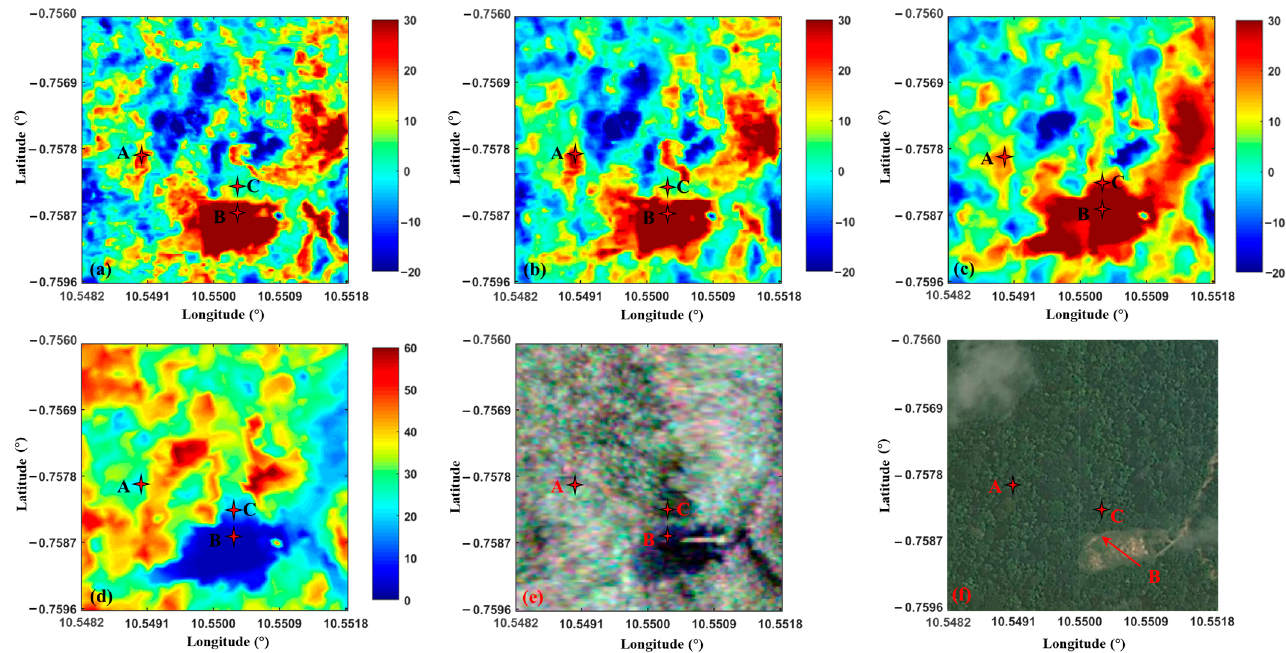
Figure 4. Estimation error of forest height results under three sizes and LiDAR forest height results in Mabounie: ( a ) 5 × 5 size; ( b ) 9 × 9 size; ( c ) 25 × 25 size; ( d ) LiDAR forest height; ( e ) PauliRGB image; ( f ) optical image.